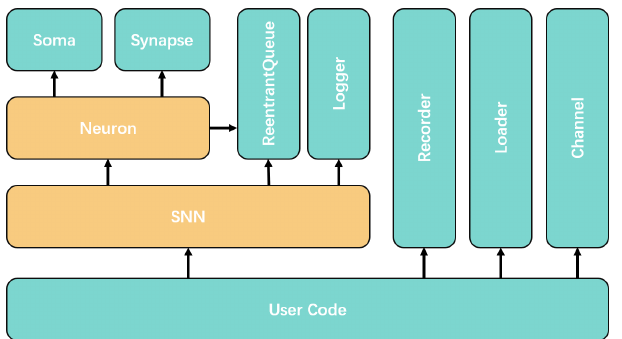
Figure 5. Structure of EDHA.The green boxes are the those that can be written by the user. The yellow ones represent those modules that cannot be modified. Arrows indicates the calling relationships between modules that are from callers to